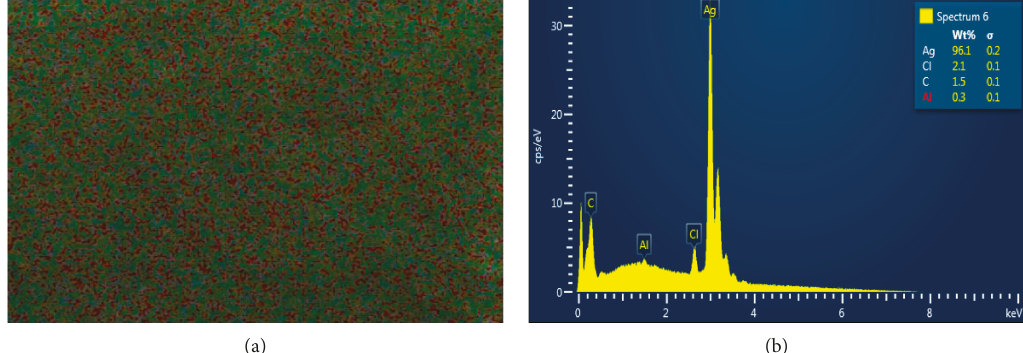
Figure 1: (a) SEM images of a nanoparticle layer for EDS analysis. (b) Quantitative spectrum of the contents of the particles in %age.